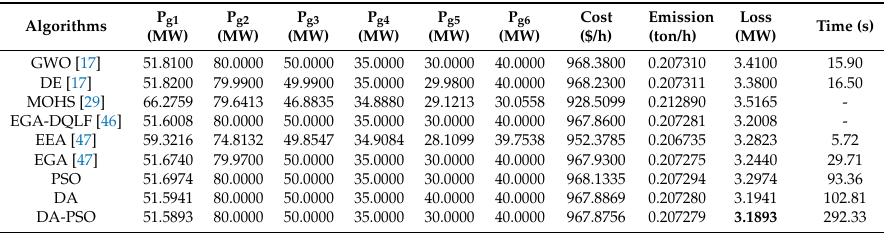
Table 4. Comparison of the results from DA-PSO and other algorithms when considering only losses as part of the objective function for IEEE 30-bus